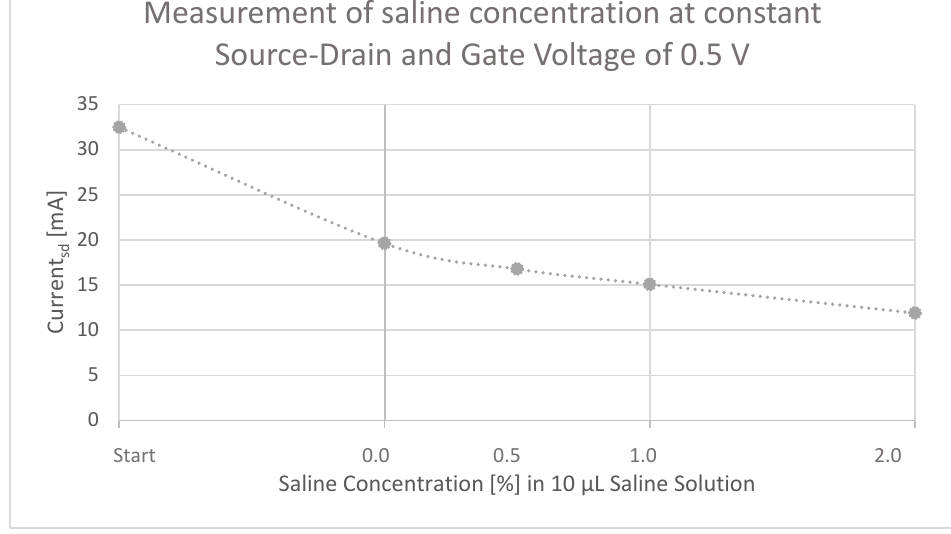
Figure 13. Mean change in current output under the addition of 10 μ L saline solution (0.9%).